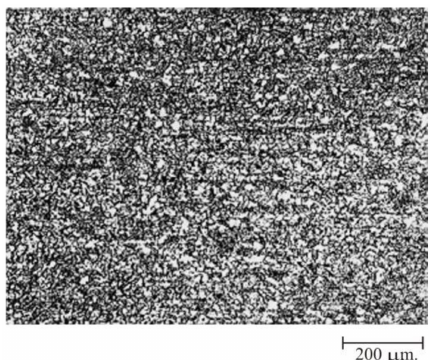
Figure 21. Ferritic-pearlitic structure of native material, etch.